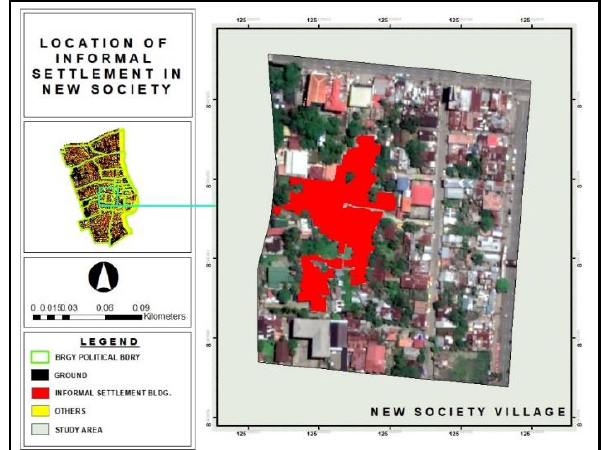
Figure 1. Classified Informal Settlement Area Map using SVM Algorithm